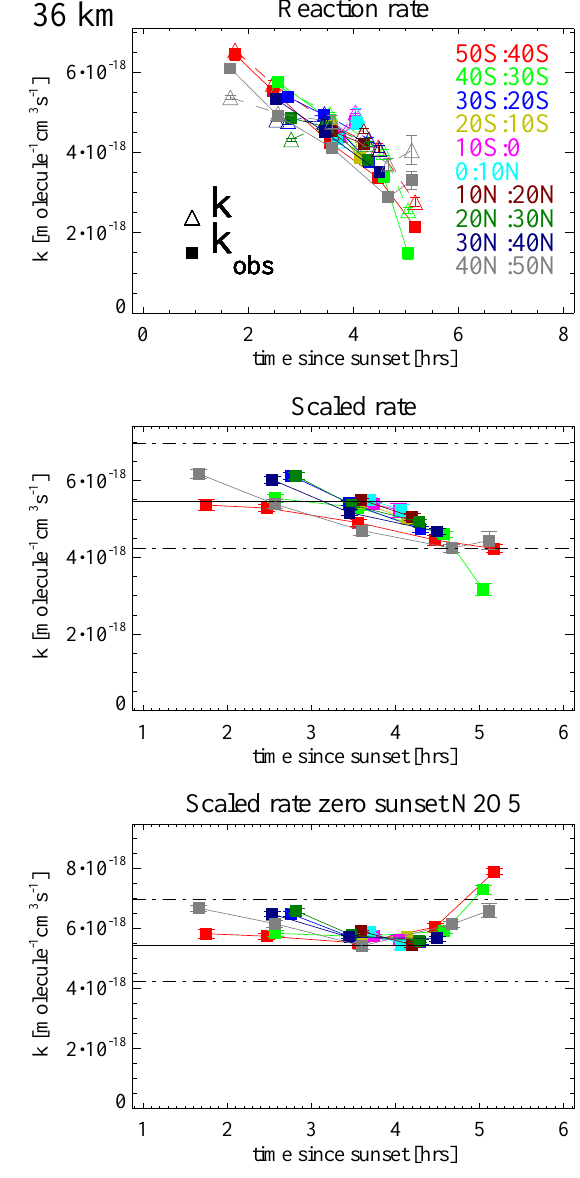
Fig. 10. Seasonal analysis grouped by hour elapsed since sunset where top panel shows k obs and Arrhenius k (computed for observed atmospheric temperature) binned in 10 ◦ latitude bands where 50–40 ◦ S is shown in red, 40–30 ◦ S in light green, 30–20 ◦ S in dark blue, 20–10 ◦ S in yellow, 10–0 ◦ S in pink, 0–10 ◦ N in light blue, 10–20 ◦ N in maroon, 20–30 ◦ N in dark green, 30–40 ◦ N in navy blue, and 40–50 ◦ N in grey. Middle panel at each altitude shows k obs scaled to the value it would assume at 245K where the sunset N 2 O 5 concentration has been estimated using the TUV. Bottom panel is as in middle panel except sunset N 2 O 5 concentrations are assumed to be negligible. The horizontal line in the middle and bottom panels indicates the Arrhenius estimate of the reaction rate at 245K.